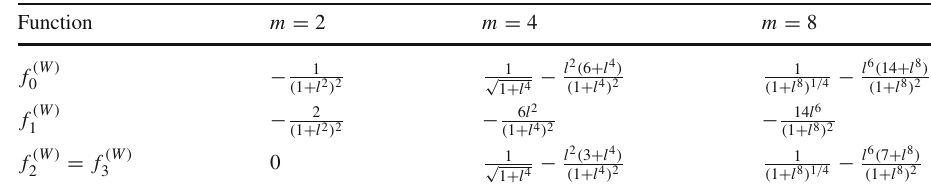
Table 1 Inequality functions, f ( W ) μ for m = 2, m = 4 and m = 8